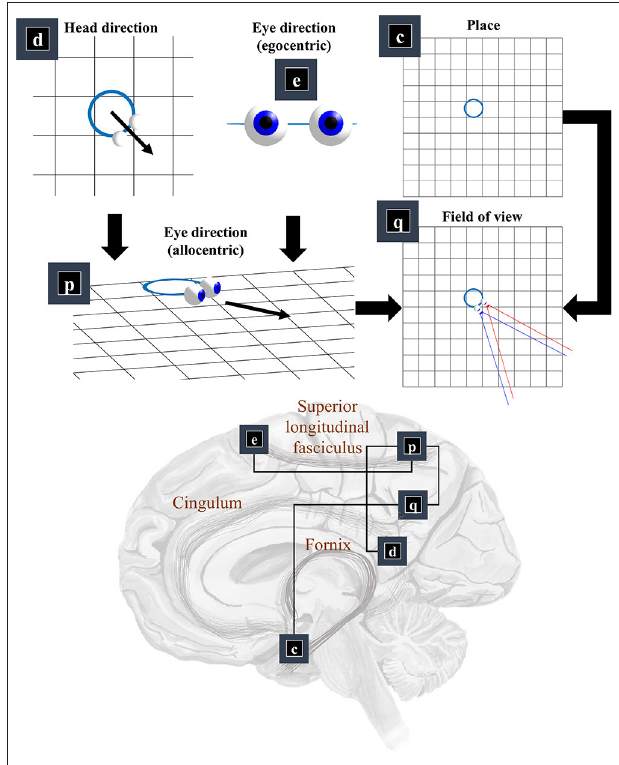
FIGURE 3 | The “where” pathway. This figure shows the factors that conspire to generate a field of view. This shows how the allocentric head and egocentric eye-directions (factors d and e ) can be combined to compute an allocentric eye-direction (factor p ). When this vector is placed so that it originates from the place (factor c ) we find ourselves in, we have our field of view (factor q ). The graphic in the lower part of this figure maps the associated factors onto the brain structures thought to be involved in representing these variables. The frontal eye-fields (factor e ) and the retrosplenial cortex (factor d ), both project to the parietal cortex (factor p ), which includes regions sensitive to allocentric eye-directions. This communicates with temporoparietal regions (factor q ), which are also accessible to hippocampal outputs (factor c ) via a pathway comprising the fornix, mammillothalamic, and cingular white matter